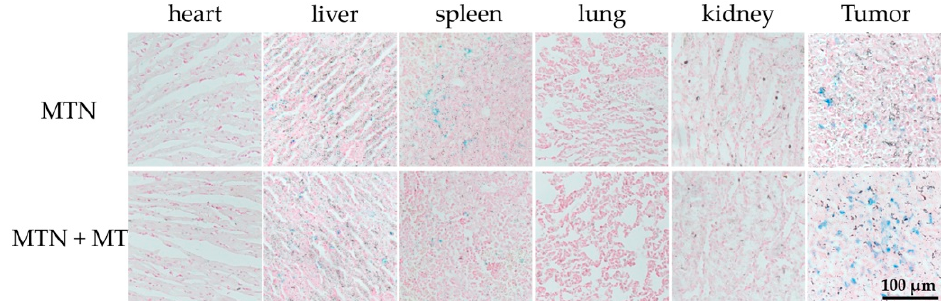
Figure 9. Tissue slices of main organs and tumors after treatments by MTN or MTN + MT. The duration time of MT was 4 h, and those tissues were obtained at 22 h after intravenous injection of MTN. These tissue slices were stained by nuclear fast red and Prussian blue simultaneously.